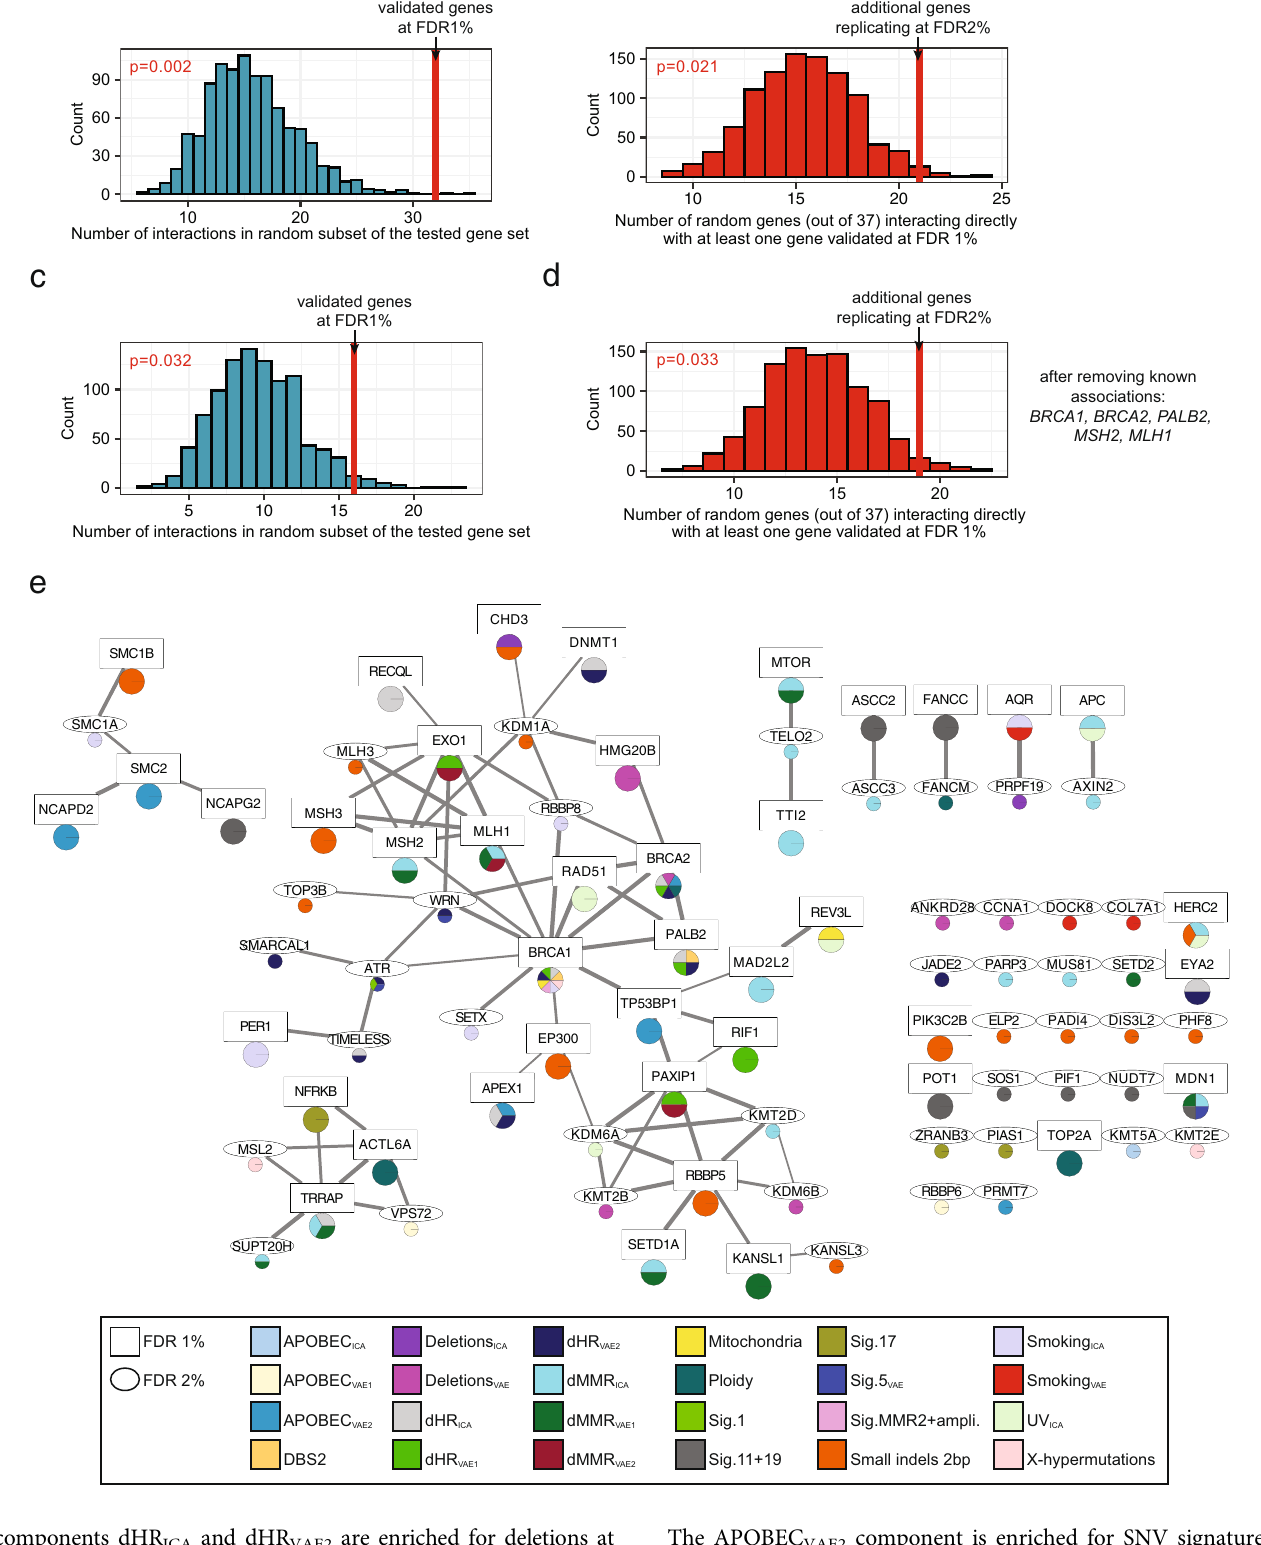
components dHR ICA and dHR VAE2 are enriched for deletions at microhomology- fl anked regions. Prior studies showed that the encoded protein APE1 protein plays a role in the repair of DSBs and that depletion of APE1 leads to an decrease of HR-directed repair 95 , suggesting a higher reliance on alternative